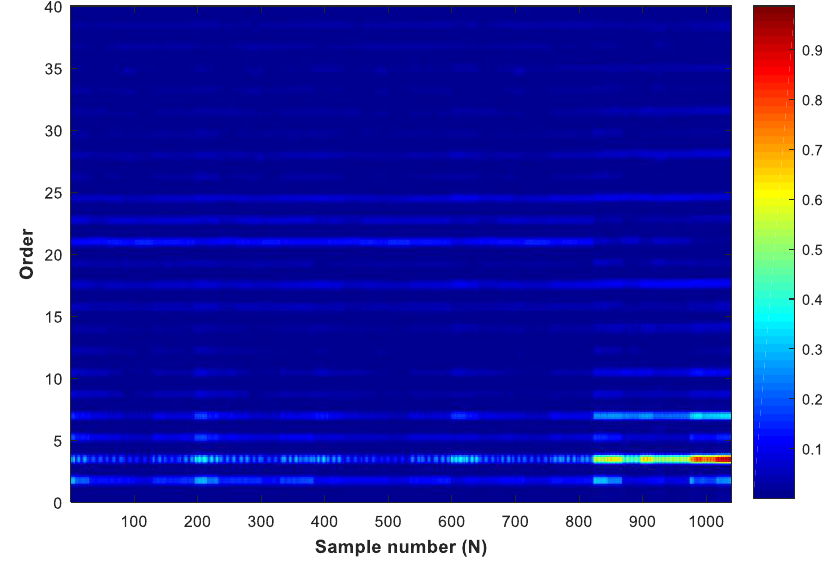
Figure 7. The picture of the order spectrum.